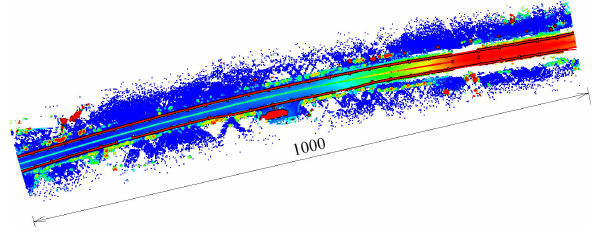
Figure 3 . MLS point cloud acquired with Lynx Mobile Mapper M1 for Stantsionnaya street.